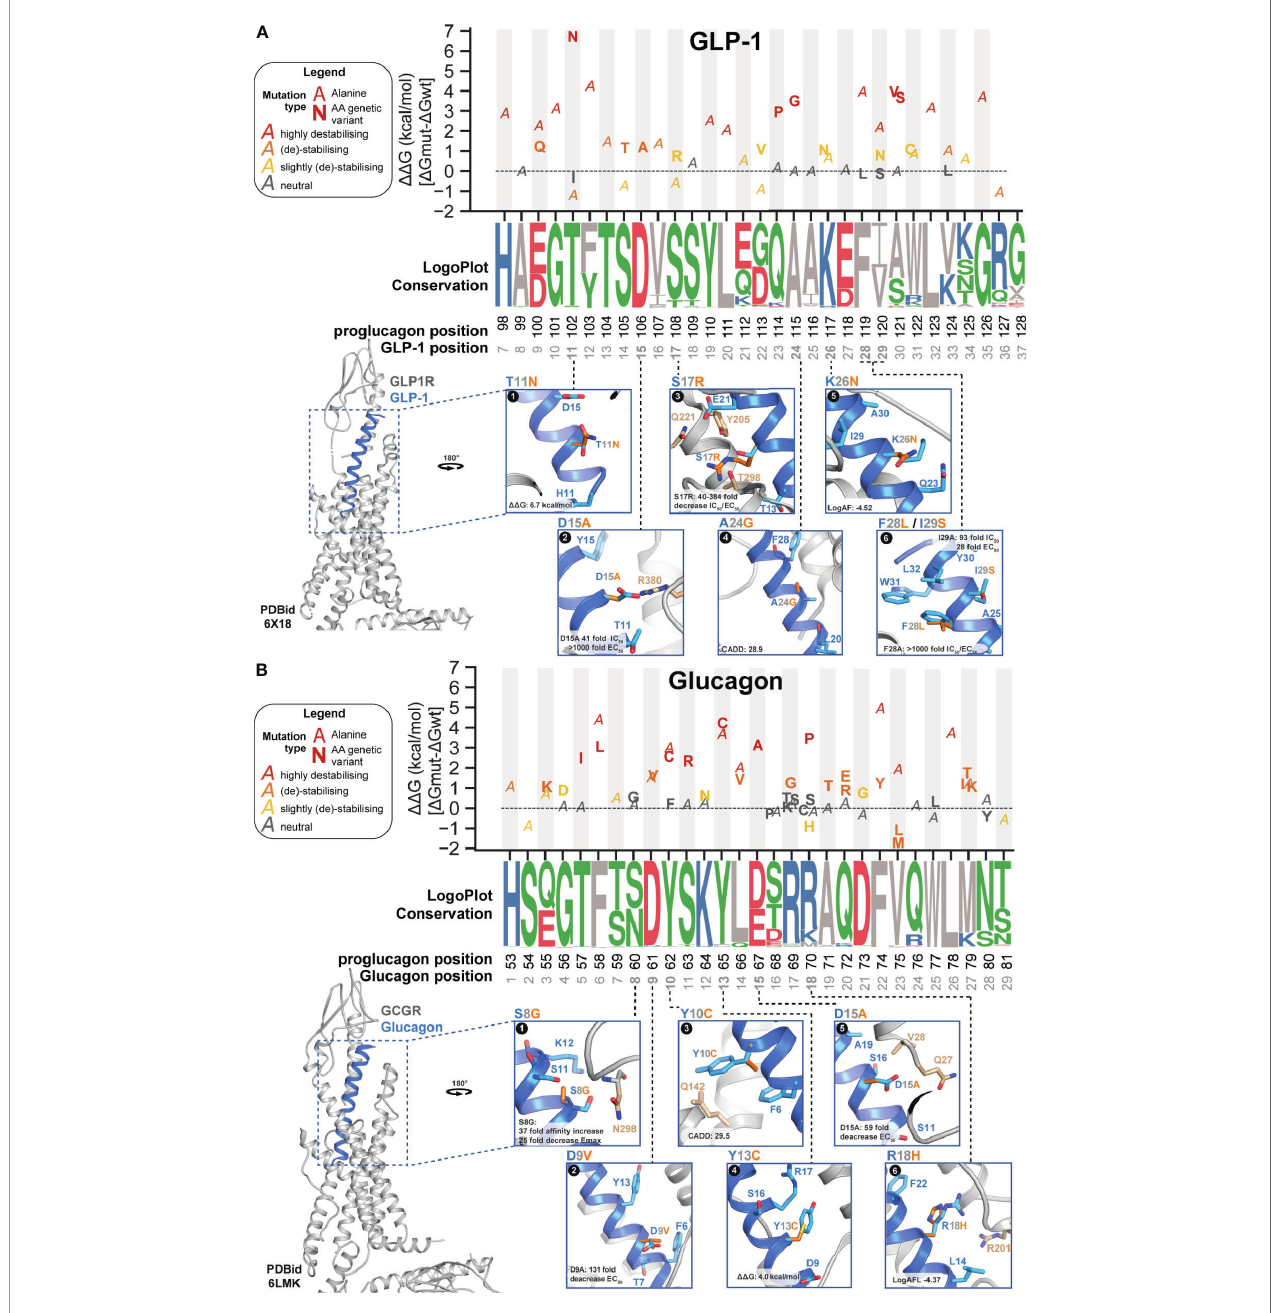
FIGURE 4 | Proglucagon peptide hormone receptor structure and ligand-interaction with wild type (WT) or mutant genetic variant. (A, B) Predicted binding af fi nity changes ( top panel ) DD G (kcal/mol) for genetic variations (glucagon: n=17; GLP-1: n=34) and alanine substitutions based on DD G energy calculations on 10 independent runs from re fi ned structure models (GLP-1 PDBid: 6X18; glucagon PDBid: 6LMK) (56). All genetic variants (marker: amino acid variant in bold ) found in the combined set of genetic variant data ( Figure 1A ) and alanine substitutions for all positions in the respective receptor complexes (marker: A ). Variants are colored based on different levels of energy, red (highly destabilizing), orange (destabilizing), yellow (slightly destabilizing), and grey (neutral). Evolutionary conservation on logo- plots (57) based on a multiple-sequence alignment (from Ensembl Compara (58),) of 222 high-con fi dence orthologues from 164 vertebrates (including in-paralogs). Each letter ’ s height represents the frequency within the aligned sequences ordered from the most conserved on the top of the letter stack. Polar contacts to the selected WT peptide position displayed in stick format. Peptide residues ( light blue ), genetic variant ( orange ), receptor residues ( beige ). Max fold change in IC 50 and EC 50 for the genetic variants presented with CADD score describing the genetic variant ’ s predicted deleteriousness. (A) Representation of glucagon-like peptide-1 receptor (GLP-1R) structure ( grey ) in complex with GLP-1 7-36-NH2 ( blue ) (PDBid: 6X18). (B) Representation of the glucagon receptor (GCGR) structure ( grey ) in complex with glucagon 1-29 ( blue ) (PDBid: 6LMK). See SI3 and SI4 for more